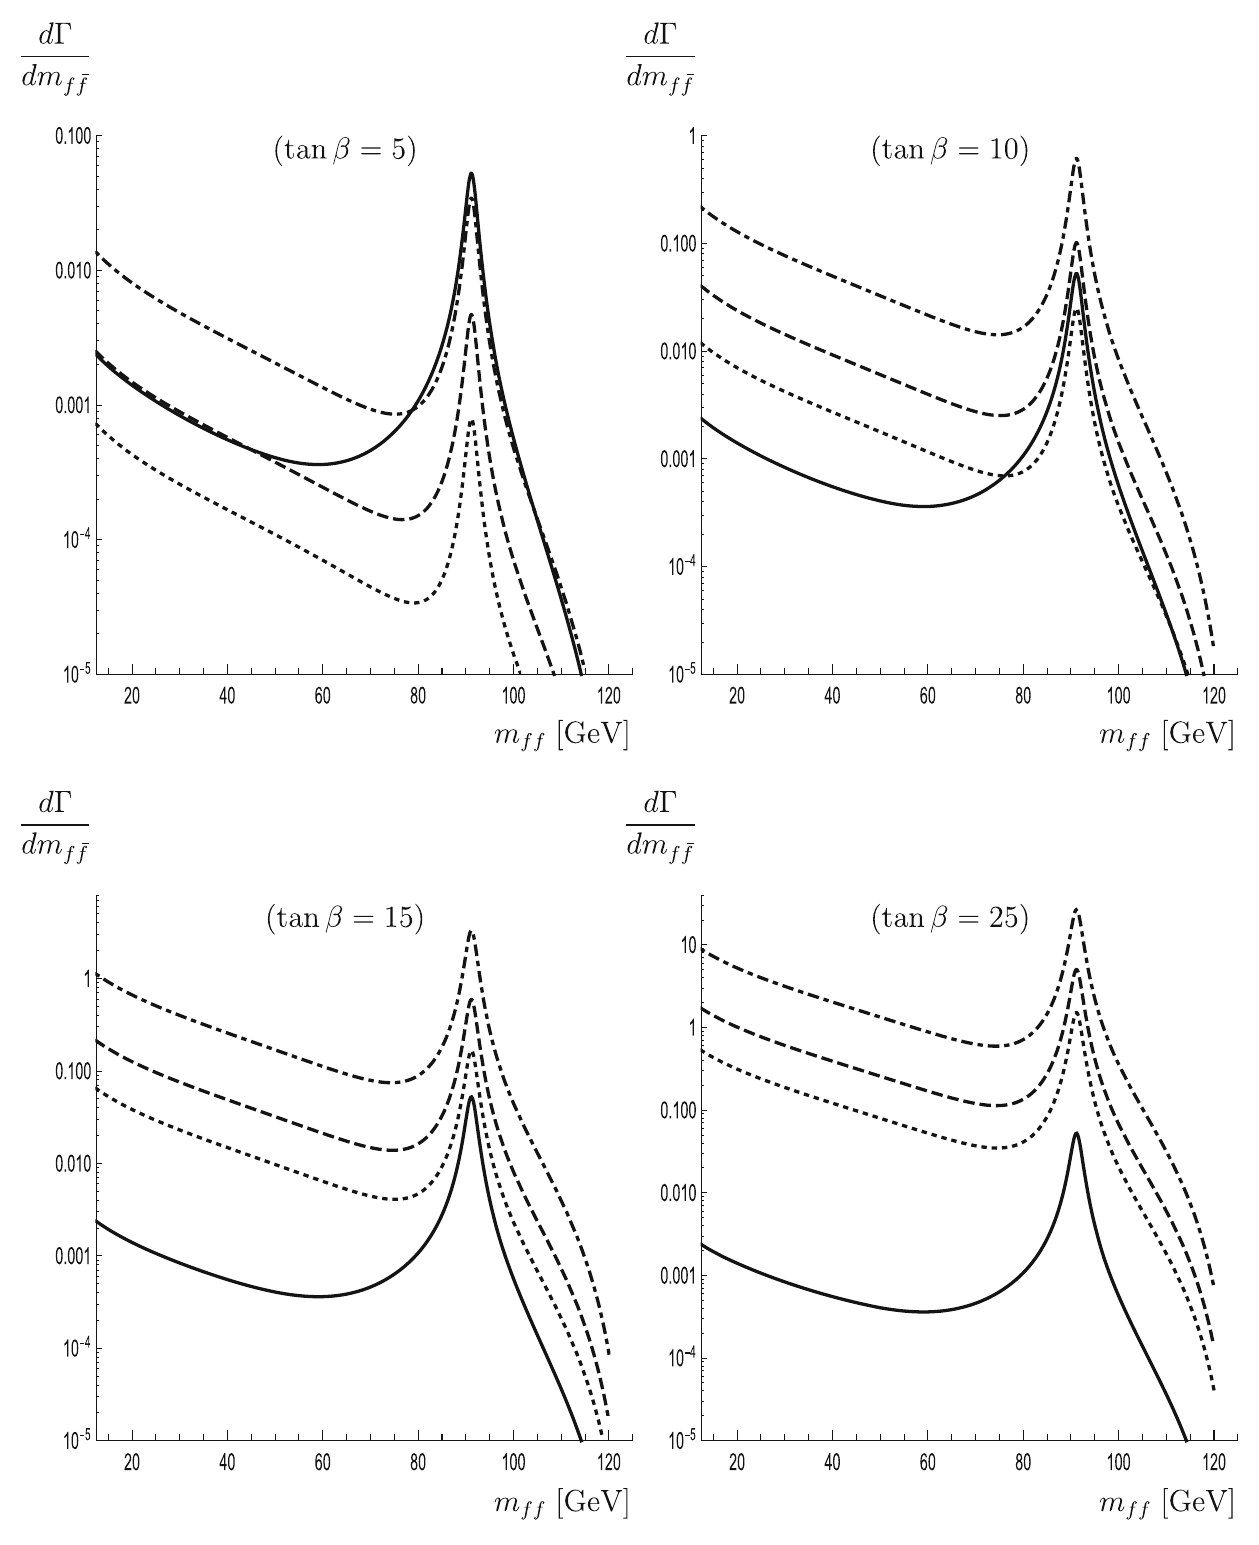
Fig. 17 Differential decay rates as a function of the invariant mass of leptons m f f with changing charged Higgs masses M H ± = 400 , 600 , 800